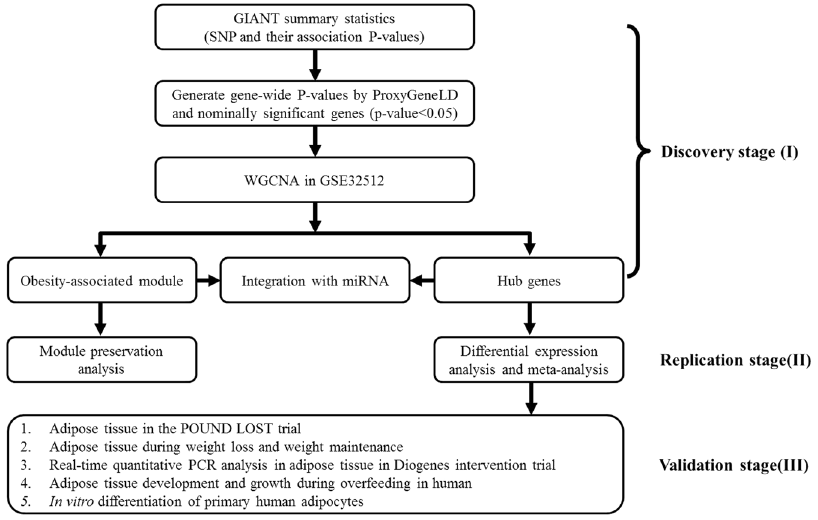
Figure 1. Systems genetics framework for underlying molecular mechanisms of obesity. A three-stage approach was